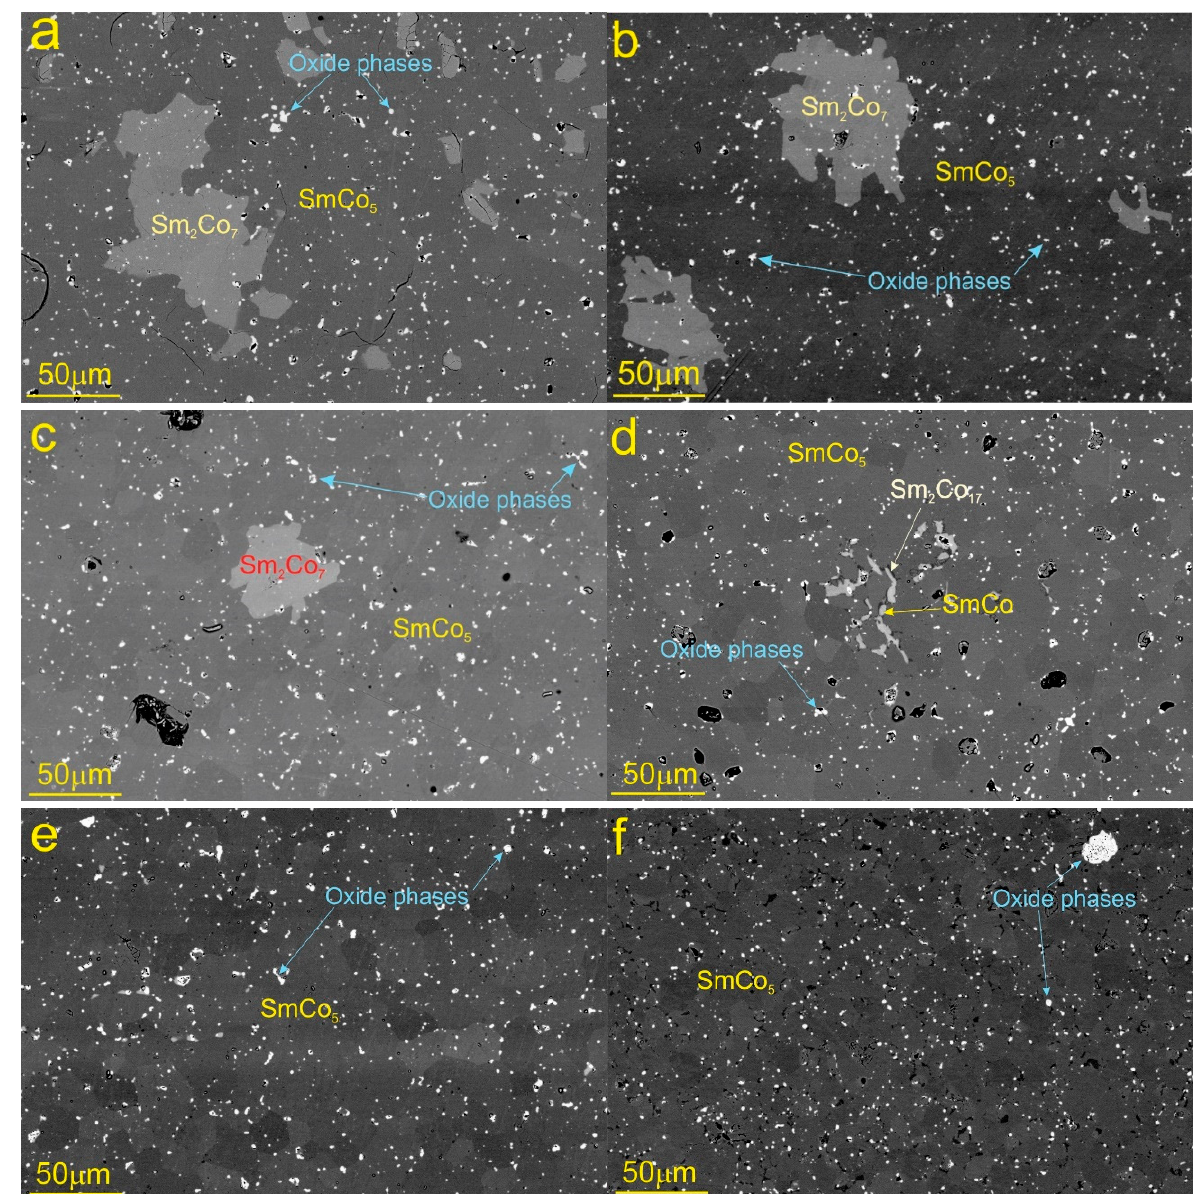
Figure 2. BSE images for the samples with ( a ) 0 wt%, ( b ) 0.5 wt%, ( c ) 1 wt%, ( d ) 2 wt%, ( e ) 3 wt% and ( f ) 4 wt% Ni/Cu, from left to right. For the magnets with Ni/Cu ≥ 3 wt%, the SmCo and Sm 2 Co 17 phases were homogeneously distributed in the microstructure, mainly at the grain boundaries, in contrast to the magnet with Ni/Cu of 2 wt% and more where the phases appear only as random clusters.